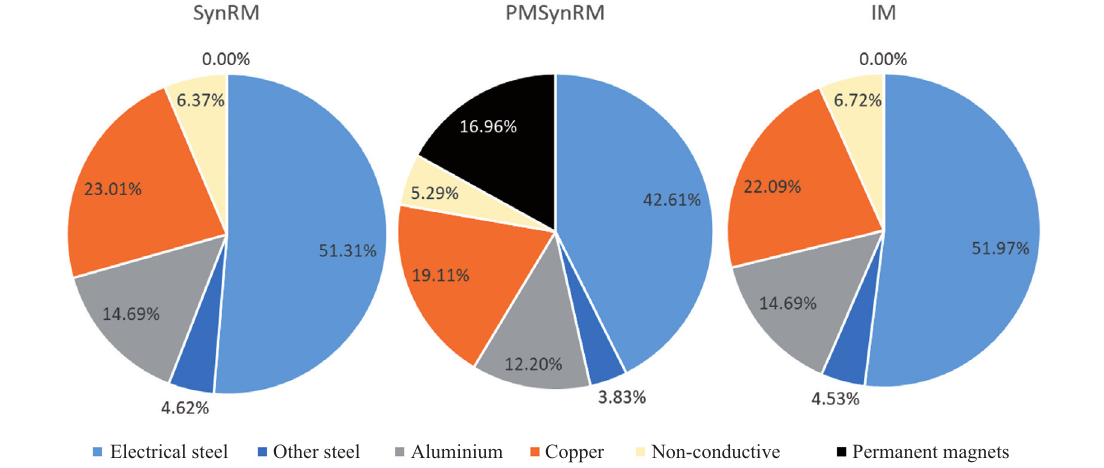
Fig. 7. Percentage ratio of raw material price based on different 10 kW motors